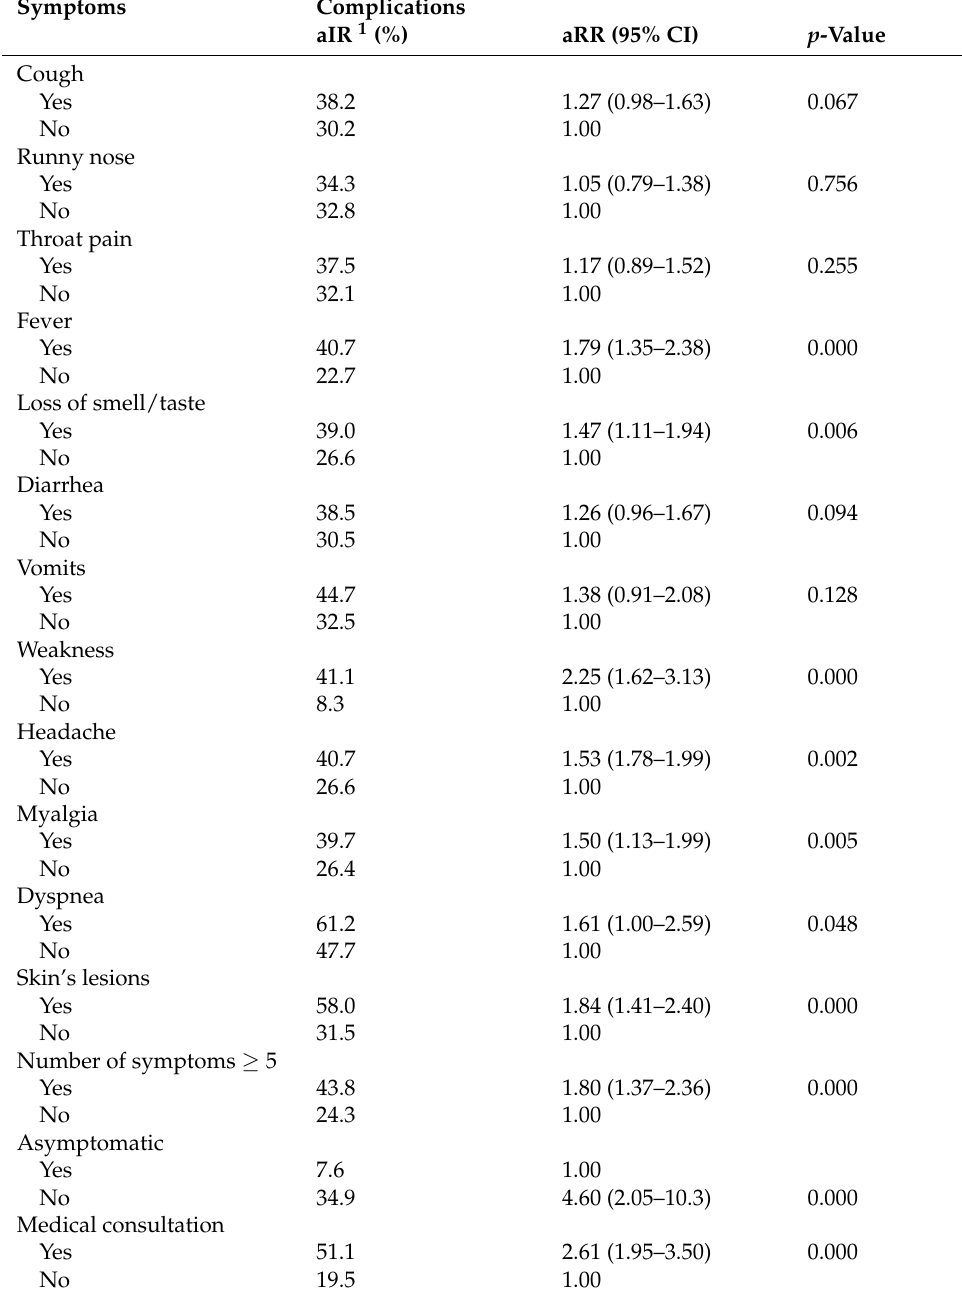
Table 3. Symptoms of acute COVID-19 illness and complications by adjusted incidence rate (aIR) and adjusted relative risk (aRR). Borriana COVID-19 cohort